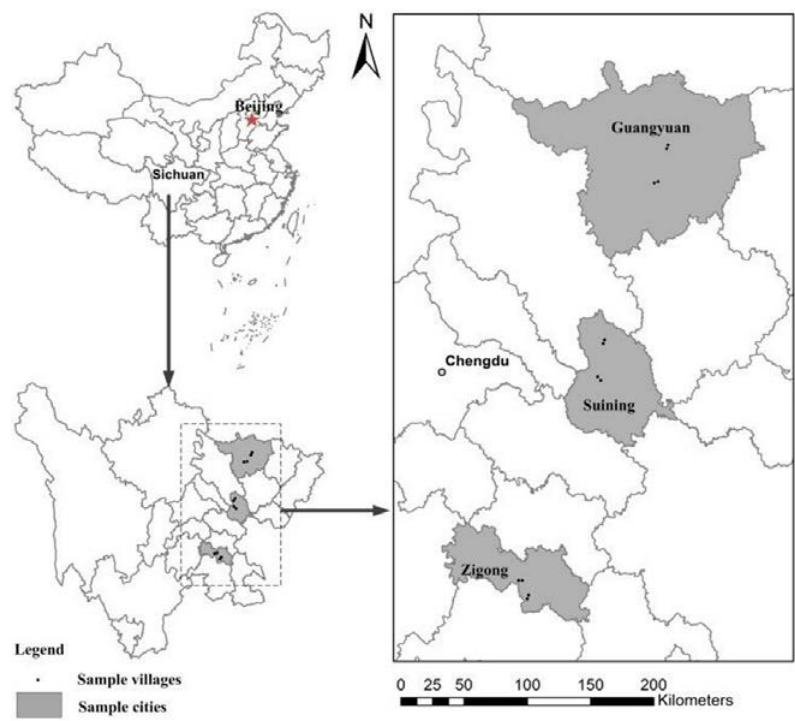
Figure 1. The spatial locations of the sample